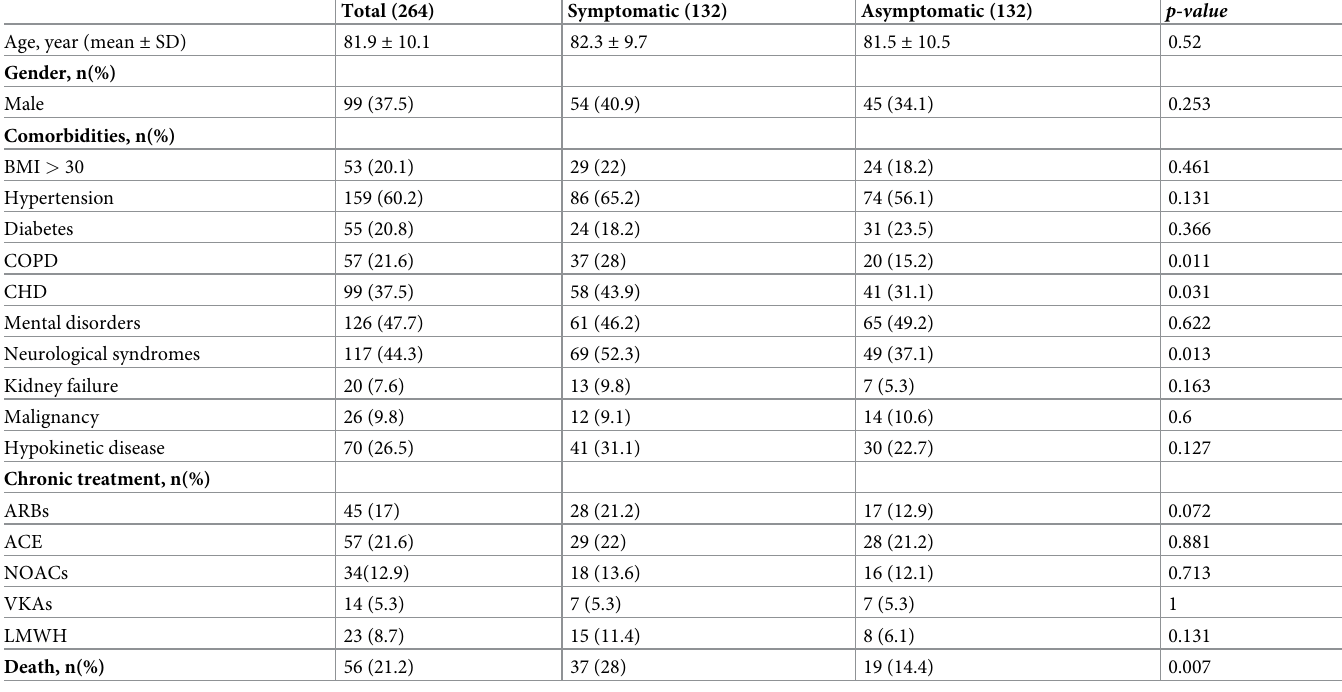
Table 2. Comparison of characteristics of 264 people living in retirement nursing homes with SARS-CoV-2 infection, divided into people with (132) and without (132) SARS-CoV-2 related symptoms.